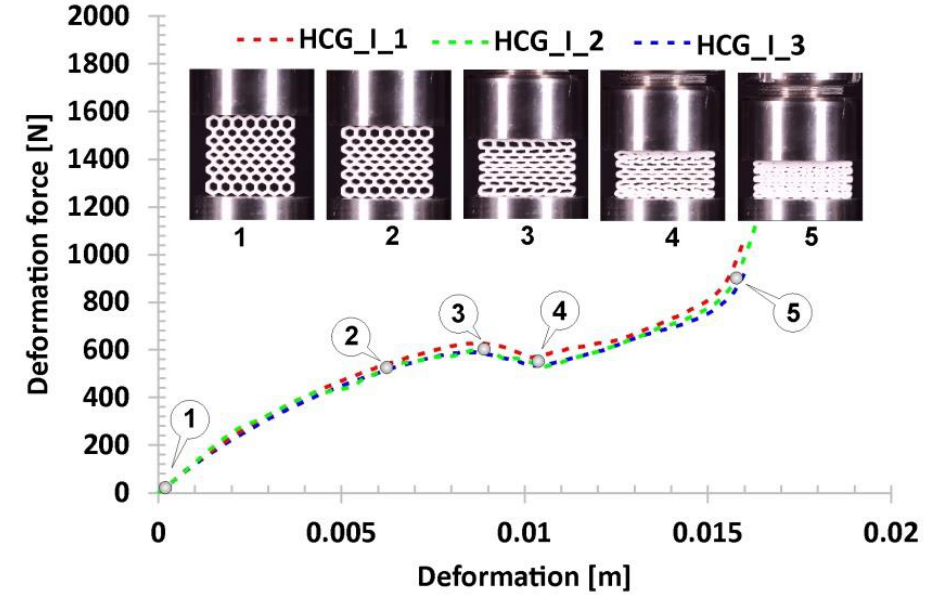
Figure 15. The results of the compression tests of the structural specimen with gradually increasing honeycomb topology.